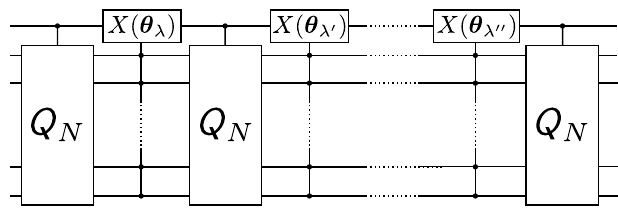
FIG. 1. The quantum circuit that generates an exact unitary t - design on N + 1 qubits from those on N qubits. The unitary Q N is a quantum circuit for an exact unitary t -design on N qubits. The gate X ( θ λ ) is the single-qubit X -rotation controlled by the other N qubits, which corresponds to R X ( θ λ ) in the main text. Note that this gate can be decomposed into a sequence of two- ( j ) qubit gates using a classical oracle that provides θ λ from j . The rotation angles θ λ are obtained by solving Z ( D ) λ = 0, where Z ( D ) λ is the zonal spherical function for the spherical representation ( D , 2 D , t ) with D = 2 N . The number of the controlled- X λ ∈ (cid:5) sph rotations is | (cid:5) sph ( D , 2 D , t ) | . By the inductive use of this quan- tum circuit in terms of N , we can decompose the circuit to that consisting only of two-qubit